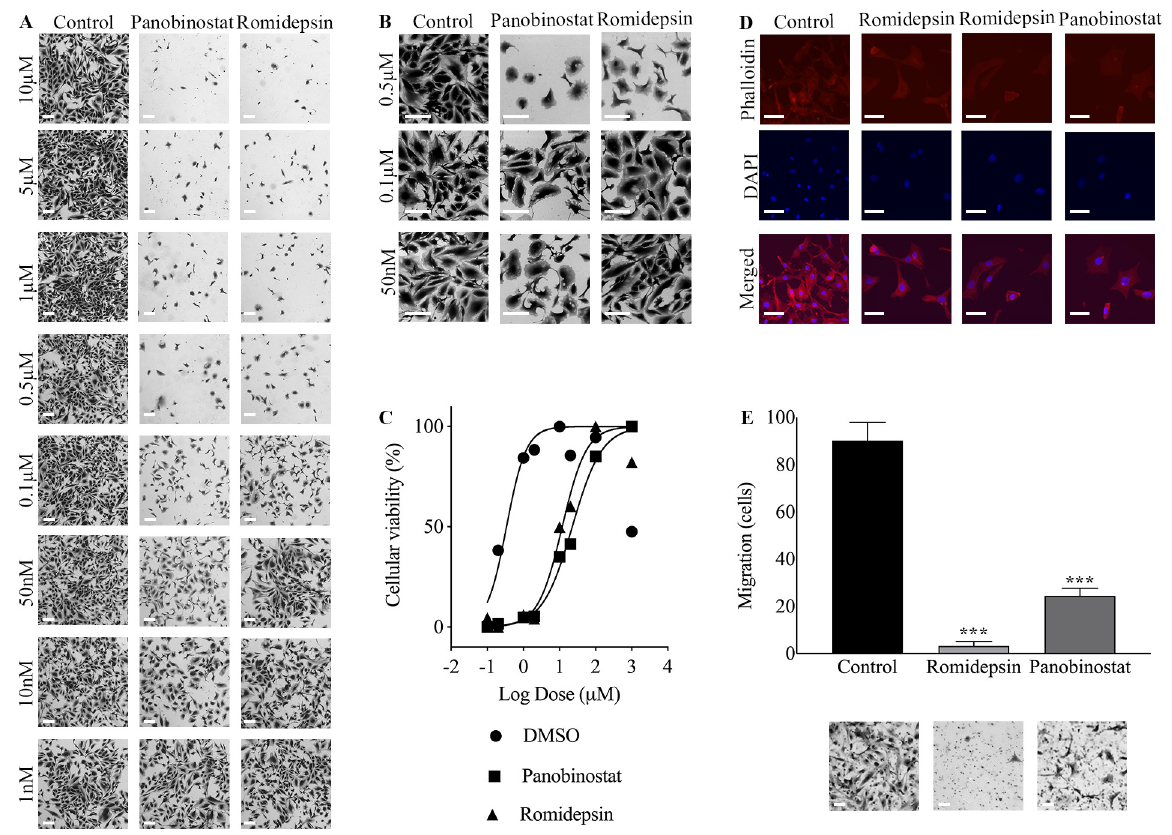
Fig 1. Dose-dependent response to panobinostat or romidepsin in adherent TU-BcX-4IC cells. TU-BcX-4IC cells were plated and treated with serial dilutions of panobinostat, romidepsin, or DMSO control for 72 hours. Cell viability and morphology were compared to DMSO control. Images were captured at 4X and 10X. (A) Panobinostat and romidepsin treatment to TU-BcX-4IC adherent cells demonstrate cytoxicity at 50 nM and 0.1 μ M, respectively. Representative images are shown at 4X magnification. (B) Panobinostat and romidepsin treatment reverse the mesenchymal transition and promote epithelial-like characteristics. Representative images are higher magnifications of the samples in panel A; images are shown at 10X magnification. (C) Dose-response analysis of TU-BcX-4IC treated with panobinostat, romidepsin, or DMSO shows increased potency and efficacy of romidepsin compared to panobinostat. After crystal violet staining, plates were lysed and absorbance was measured (570 nm) and normalized to DMSO controls to quantify drug response. (D) TU-BcX-4IC cells stained with phalloidin and DAPI showed altered distribution of actin filaments in romidepsin, and panobinostat-treated cells. (E) Transwell migration of TU-BcX-4IC cells pre- treated for 72 hours with DMSO, romidepsin, or panobinostat (24 hours migration, 100 nM treatments). Error bars are represented as standard error of mean. ��� p < 0.001. All scale bars represent 0.25